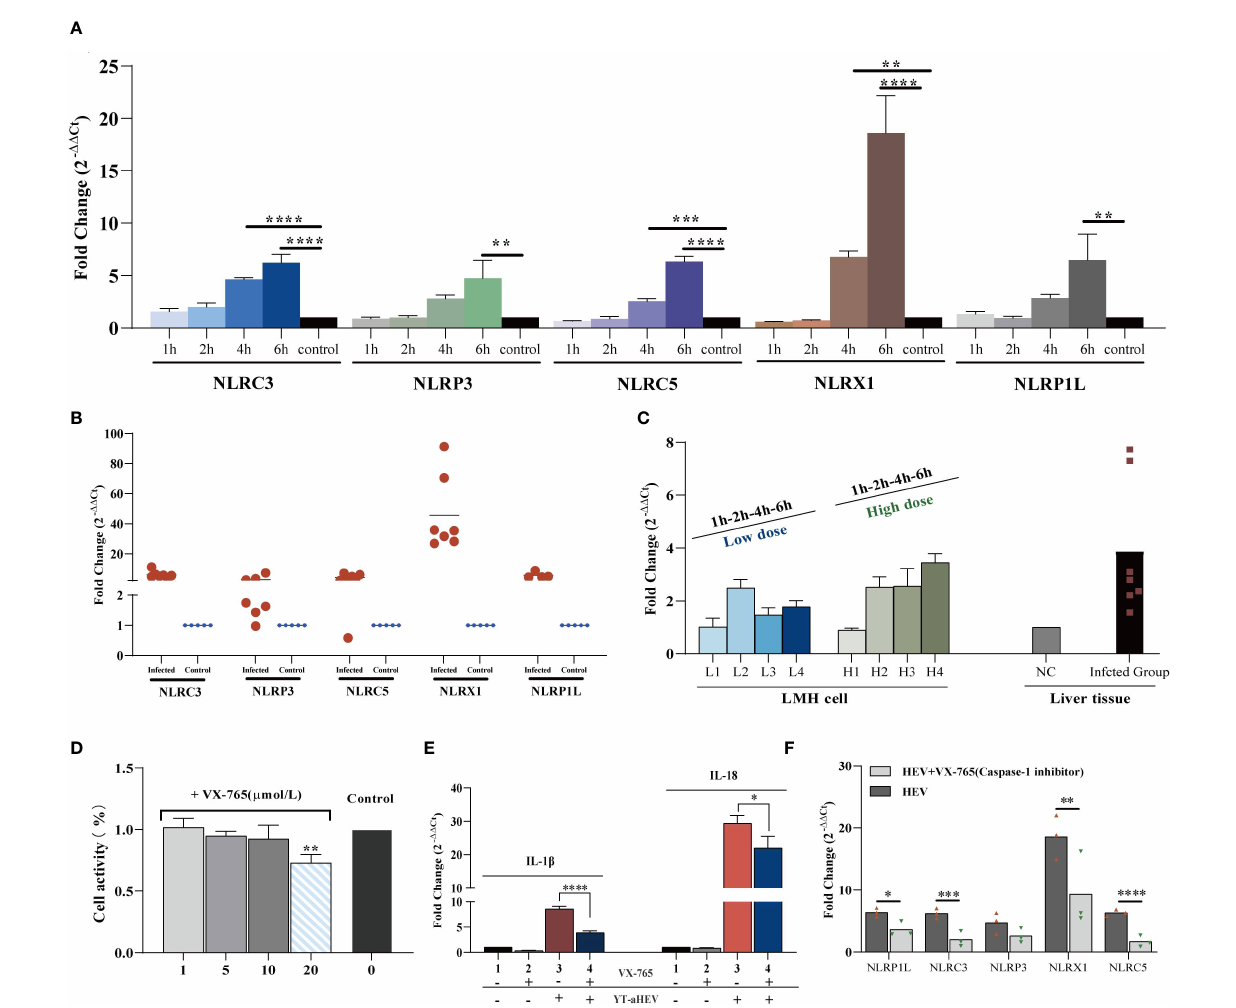
FIGURE 6 YT strain – mediated in fl ammation is caspase-1 dependent. (A) Transcriptional levels of NLRs in the LMH cell. LMH cells were infected with YT strain for 1, 2, 4, and 6 h. (B) Transcriptional level of NLRs in the liver tissue. (C) Transcriptional level of caspase-1 in the liver or LMH cell from the YT strain infected. LMH cells were infected with YT strain for 1, 2, 4, and 6 h. Two different initial infection doses were used: a high infection dose = 300